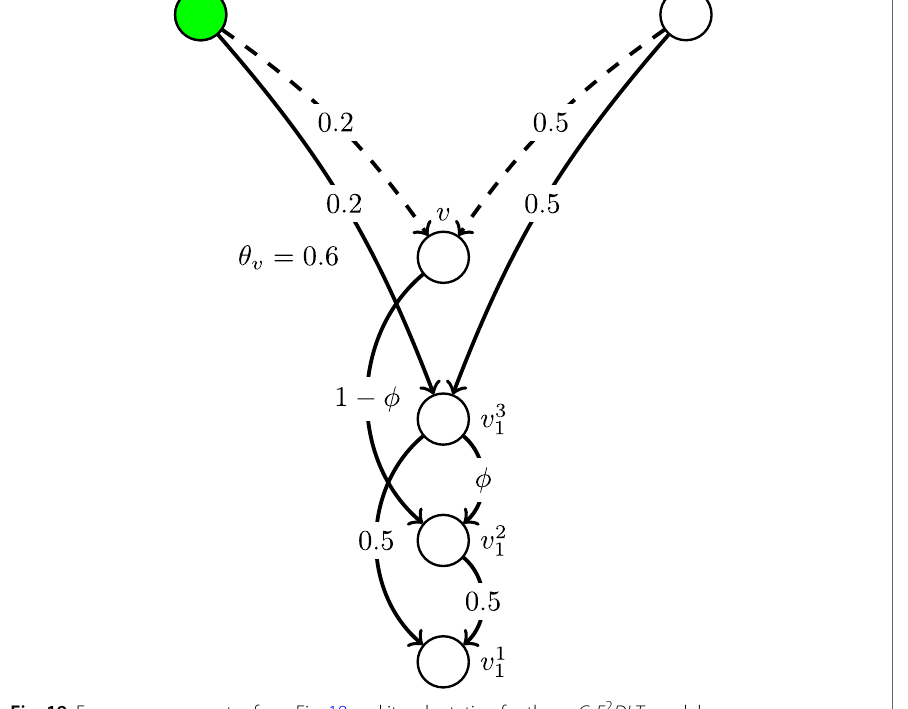
Fig. 19 Focus on a connector from Fig. 18 and its adaptation for the npC - F 2 DLT model